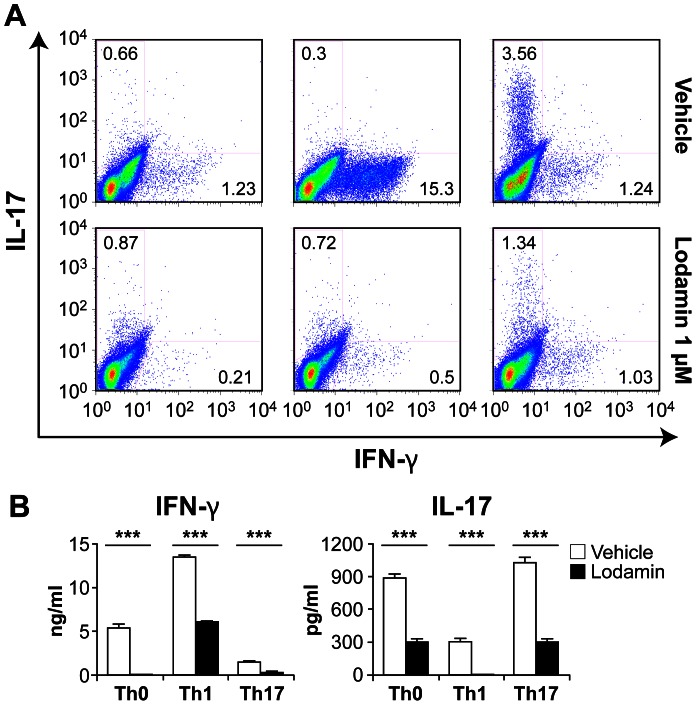
Lodamin inhibits Th1/Th17 cell differentiation by inhibiting cell proliferation and reducing the production of proinflammatory cytokines.(A) Purified CD4+CD25- T cells from spleen were activated by anti-CD3 antibody for 3 days under Th1 or Th17 polarization conditions in the presence or absence of Lodamin (1 nM), followed by stimulation with PMA and ionomycin in the presence of Brefeldin A; all plots are gated on CD4+ cells. Polarization conditions: Th0; anti-IFN-g Ab (10ug/ml) and anti-IL-4 Ab (10ug/ml); Th1; IL-12 (10 ng/ml) and anti-IL-4 Ab (10 µg/ml); Th17; IL-6 (20 ng/ml), TGFβ (2 ng/ml), anti-IFNγ Ab (10 µg/ml) and anti-IL-4 Ab (10 µg/ml) (B) Lodamin inhibits hallmark cytokine of Th1/Th17 under each polarization condition. IFN-γ and IL-17 protein level as measured by ELISA from activated cells supernatants (as describe in panel A). (mean ± SEM, n = 3, ***p<0.001).